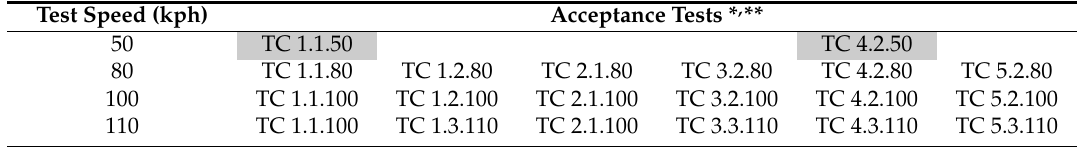
Figure 3. Crash cushion test approaches in EN 1317 Standard Part 3 [6]. Table 2. Crash testing details for crash cushions in EN 1317 part 3 [6].